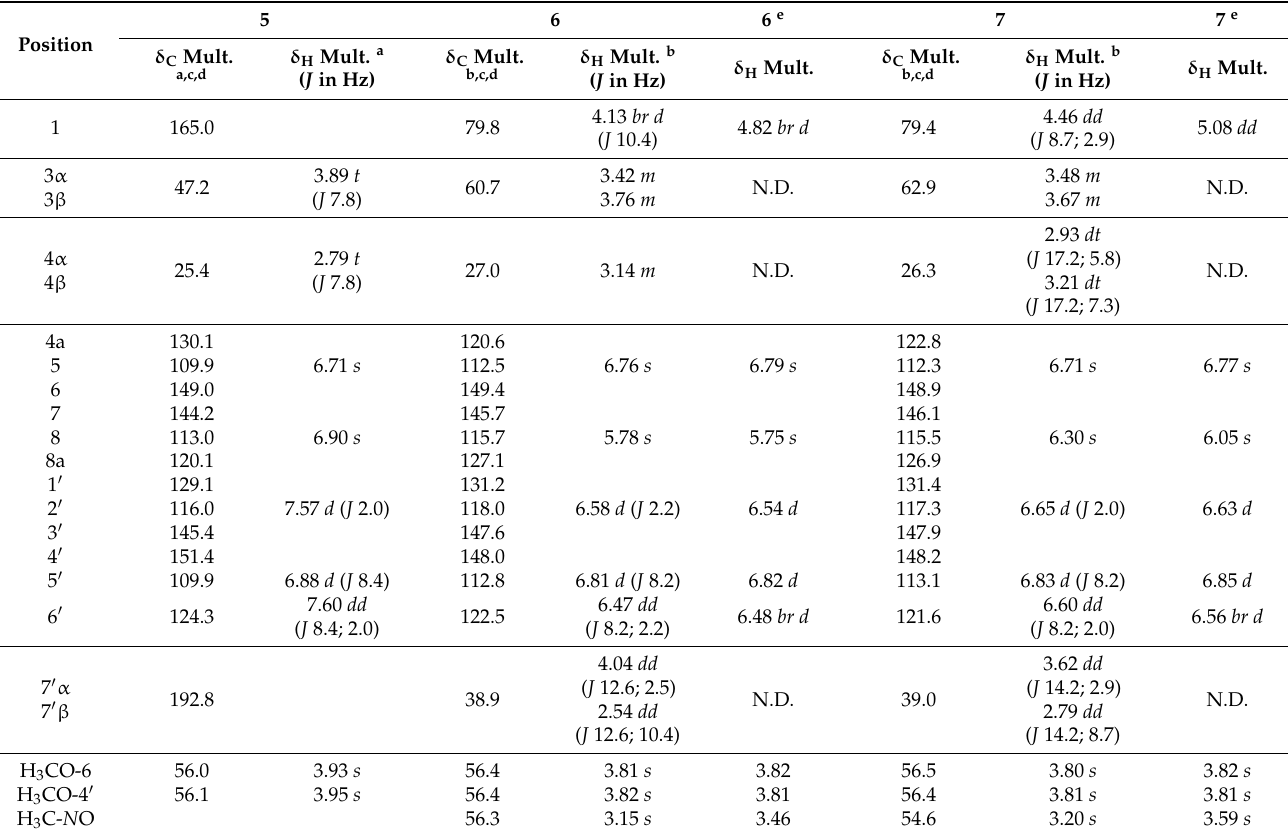
Table 1. NMR data for alkaloids 5 – 7 (500 MHz for 1 H and 125 MHz for 13 C).